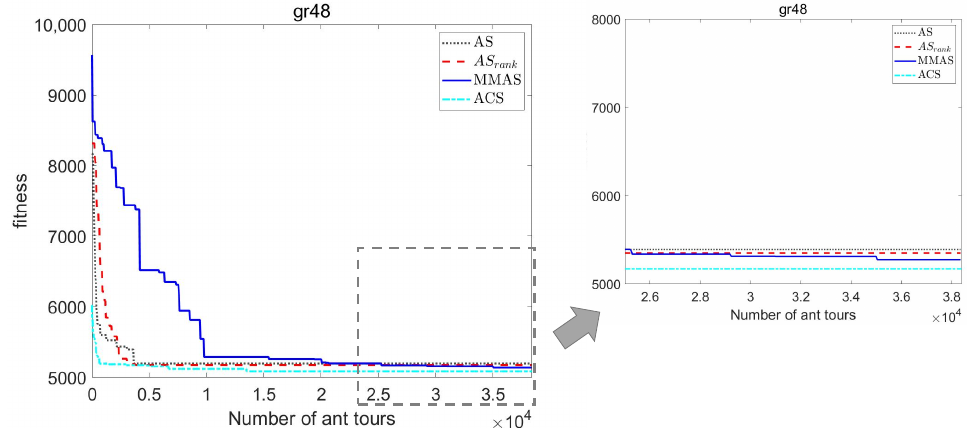
Figure 1. Evolutionary curves of ACO algorithms (AS, AS Rank , MMAS and ACS) for TSP instance gr48